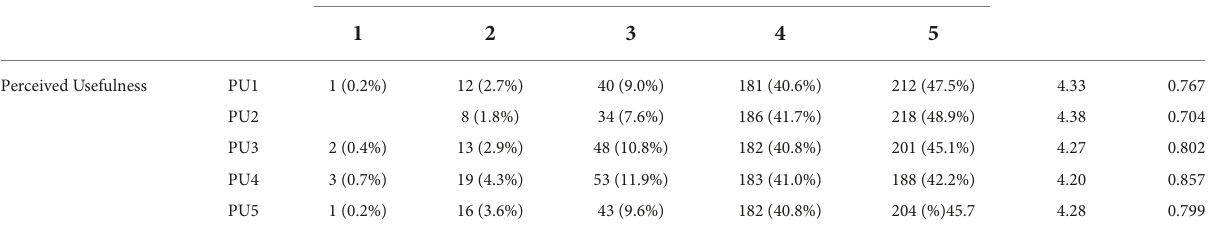
TABLE 10 Measuring perceived usefulness (PU). Factor and items Numbers and percentages of respondents